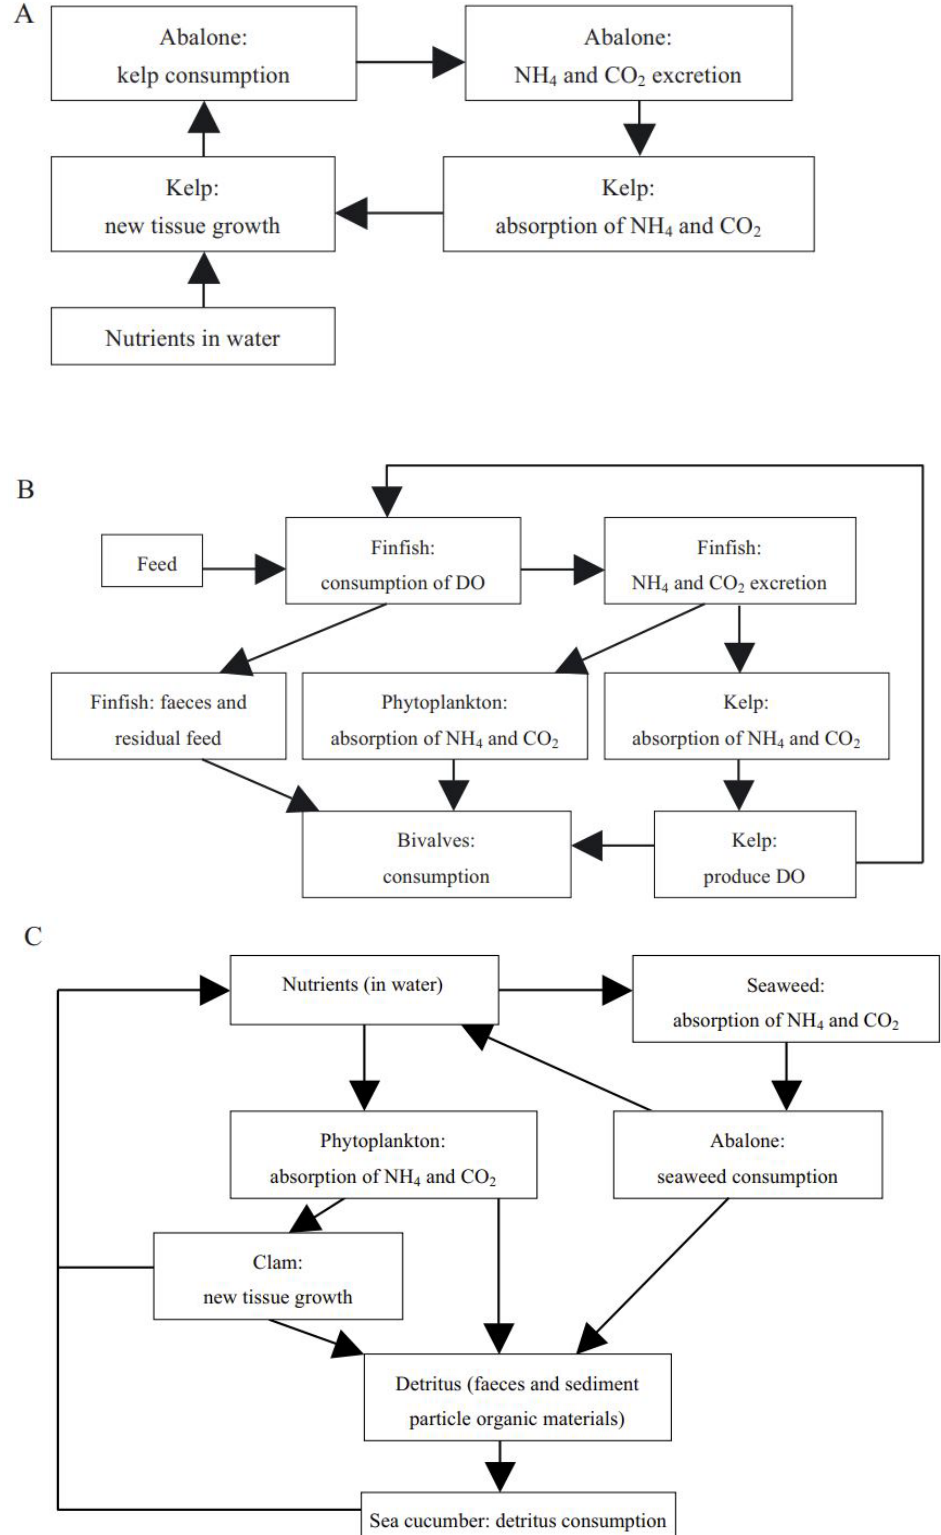
Figure 22. IMTA modes in Sanggou Bay, China. ( A ) Long-line culture of abalone and kelp, ( B ) long- line culture of finfish, bivalve, and kelp, and ( C ) benthic culture of abalone, sea cucumber, clam, and seaweed (DO—dissolved oxygen) [43].